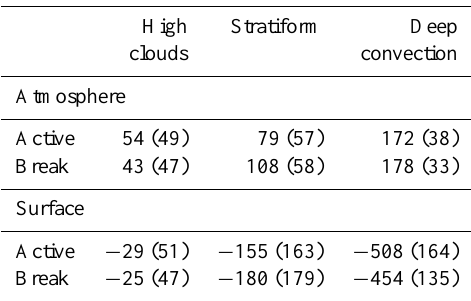
Table 2. Diurnally averaged cloud radiative effect (CRE) and its standard deviation (in brackets) of three selected cloud types aver- aged over all three zones northwards of the Equator. The months of JJAS are selected for analysis. All values are in Wm − 2 .